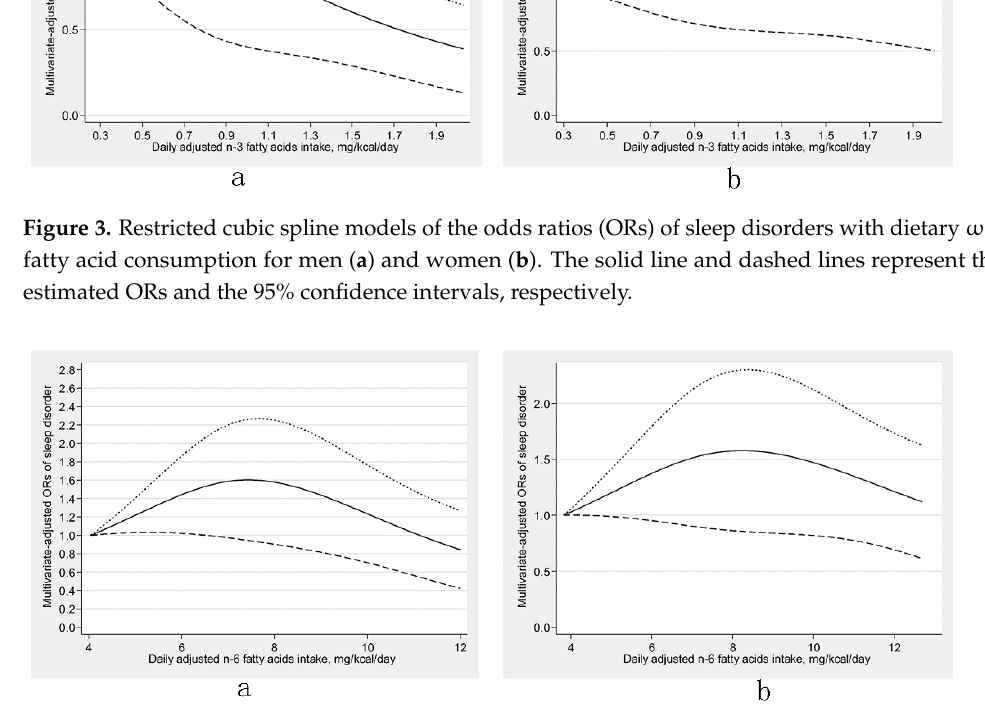
Figure 4. Restricted cubic spline models of the odds ratios (ORs) of sleep disorders with dietary ω-6 fatty acids consumption for men ( a ) and women ( b ). The solid line and dashed lines represent the estimated ORs and the 95% confidence intervals, respectively.